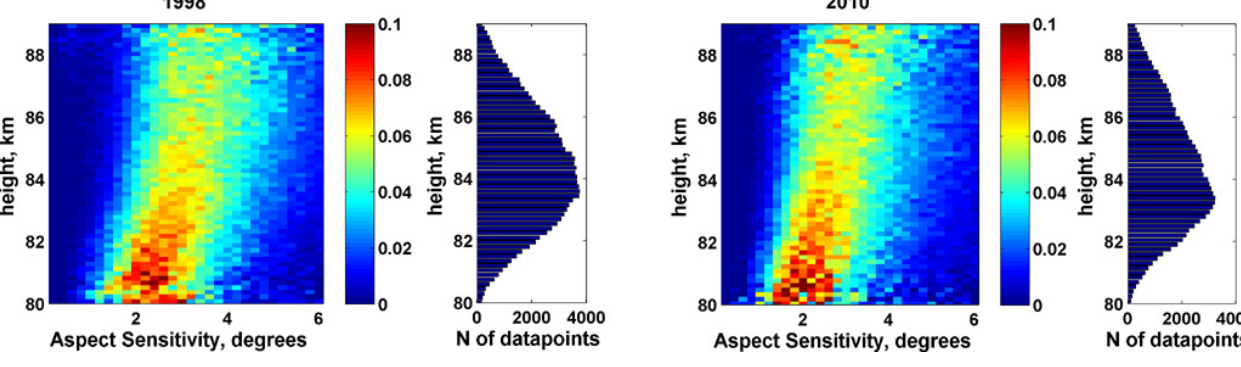
Fig. 4. The first and third panels: distribution of aspect sensitivity parameter for each 150-m altitude interval for 1998 and 2010, respectively. Each row is normalized so that the sum of all data bins in it is 1. The second and fourth panels: number N of data points contributing to each altitude interval for 1998 and 2010,